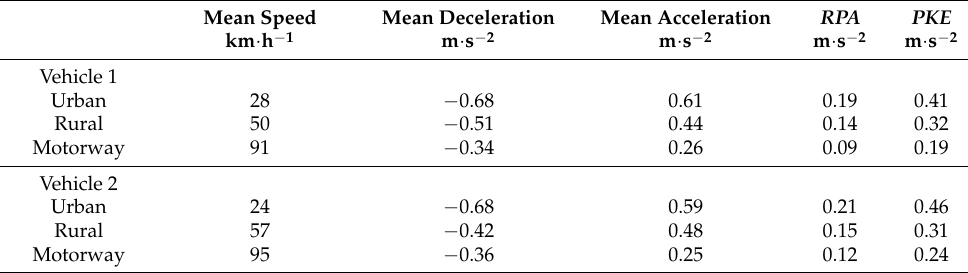
Table 3. Characteristics of the data sets in terms of vehicle